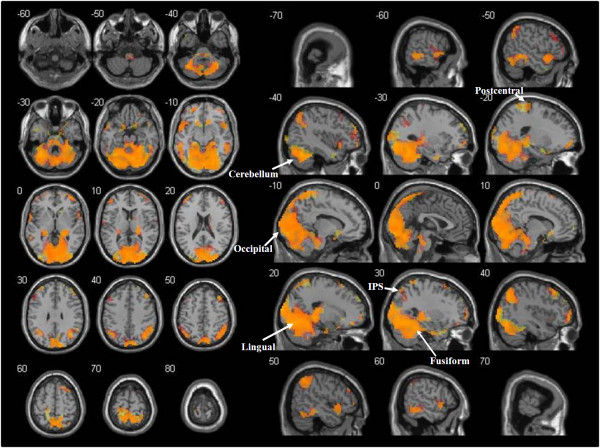
Functional activations for the representation of arm movements and dot trajectories. Cerebral regions involved in both the representation of arm movements and dot trajectories (orange) as revealed by conjunction analysis. The t-maps of AMT > IB and DTT > IB contrasts at the group level were thresholded (p < 0.05 at cluster-level, FWE corrected), binarised and multiplied voxel-wise with each other to identify common areas of activation. Areas activated only for arm movements’ representation are shown in red, while areas activated only for dot trajectories’ representation are shown in yellow. Activations are superimposed on the MNI single subject T1 template. The coordinates represented in the upper left corner of each section refer to the MNI stereotactic space.